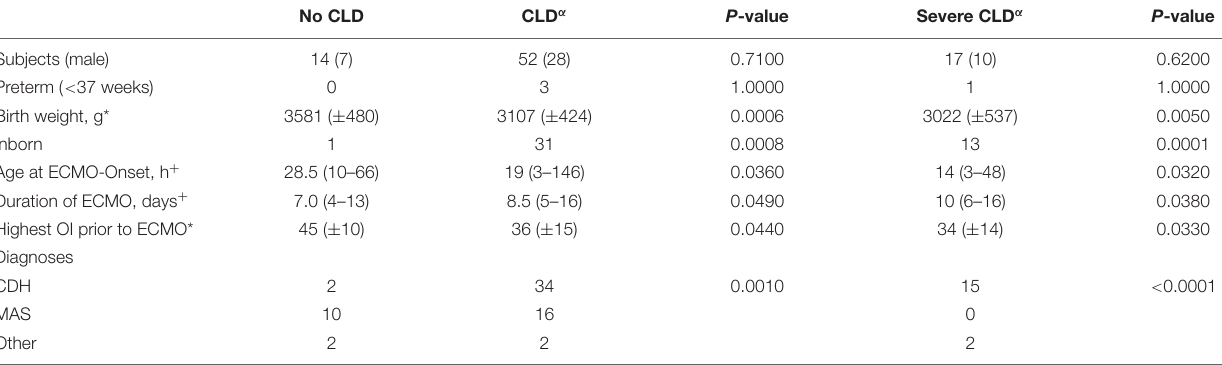
TABLE 2 | Comparison of clinical perinatal characteristics between patients with and without chronic lung disease.